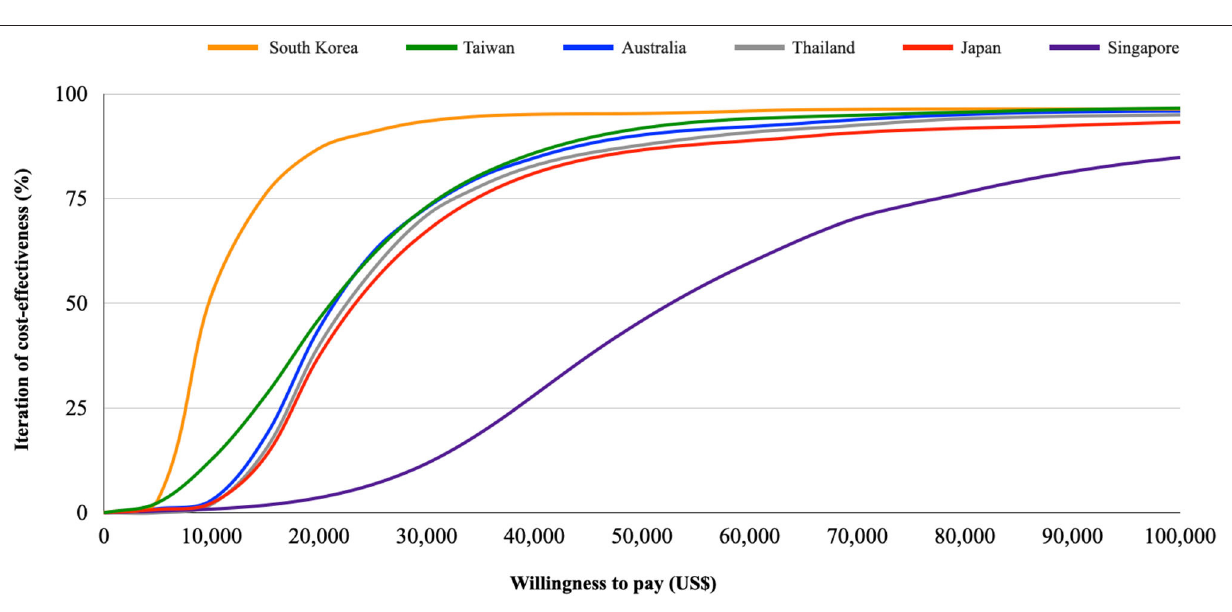
cost-effectiveness results are presented in Table 2 , and the original model is shown in Supplementary Figure 5